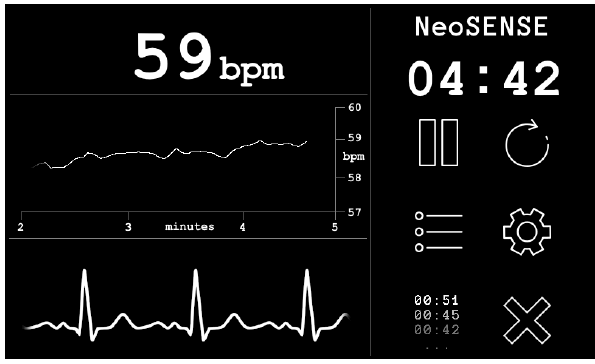
Figure 8. Screenshot of prototype graphical user interface.